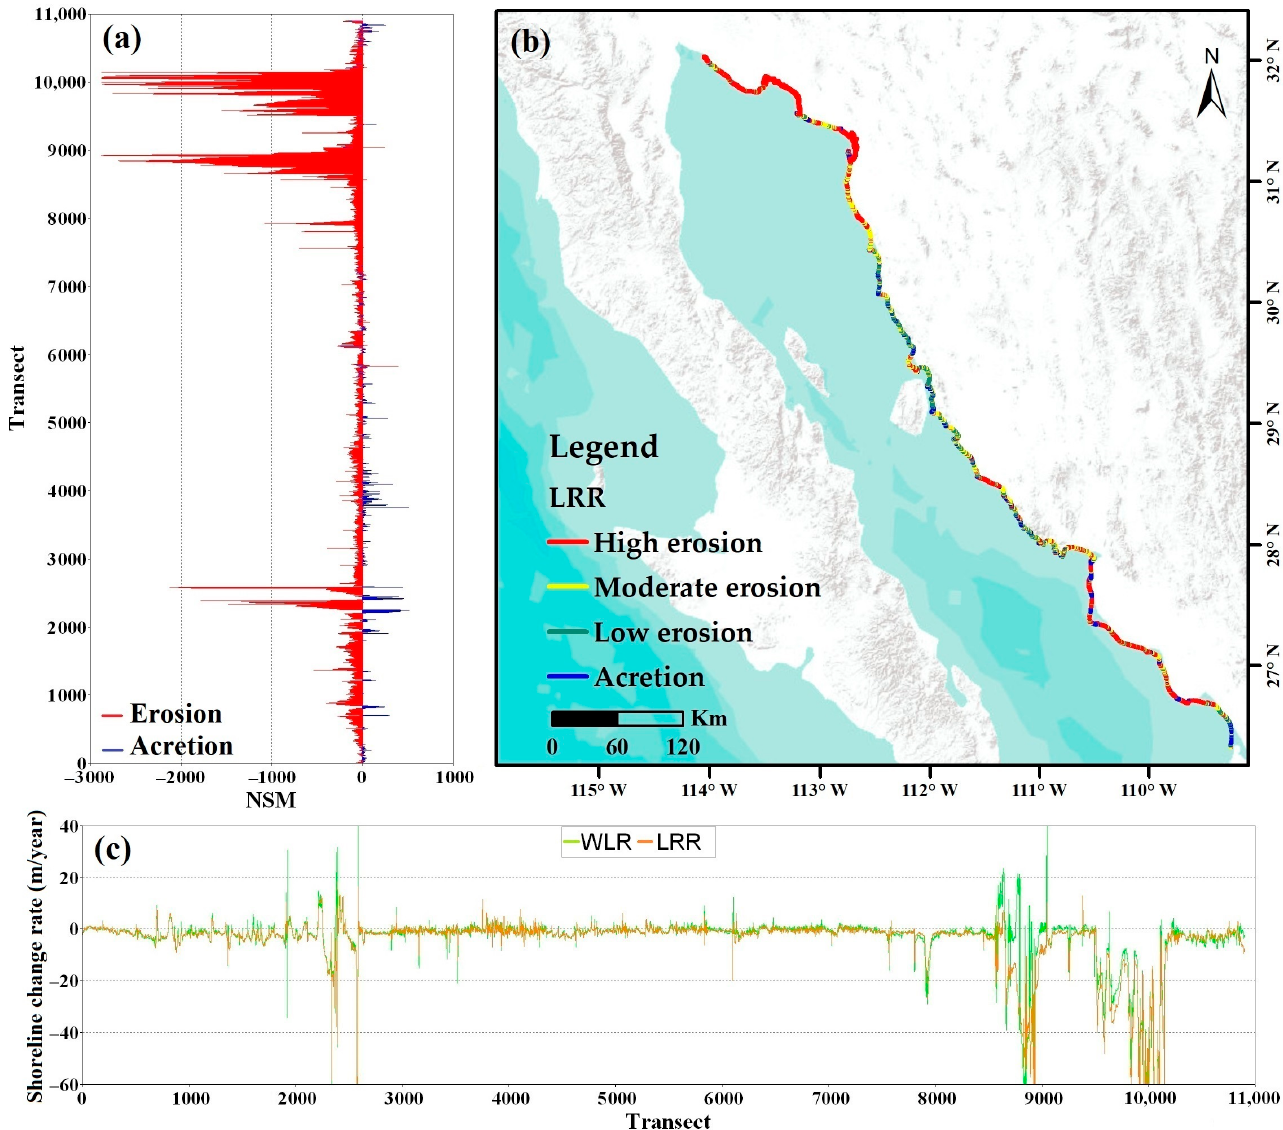
Figure 6. Shoreline dynamics and evaluation, ( a ) NSM (m), ( b ) LRR (m/year), and ( c ) WLR (m/year) along Sonora.